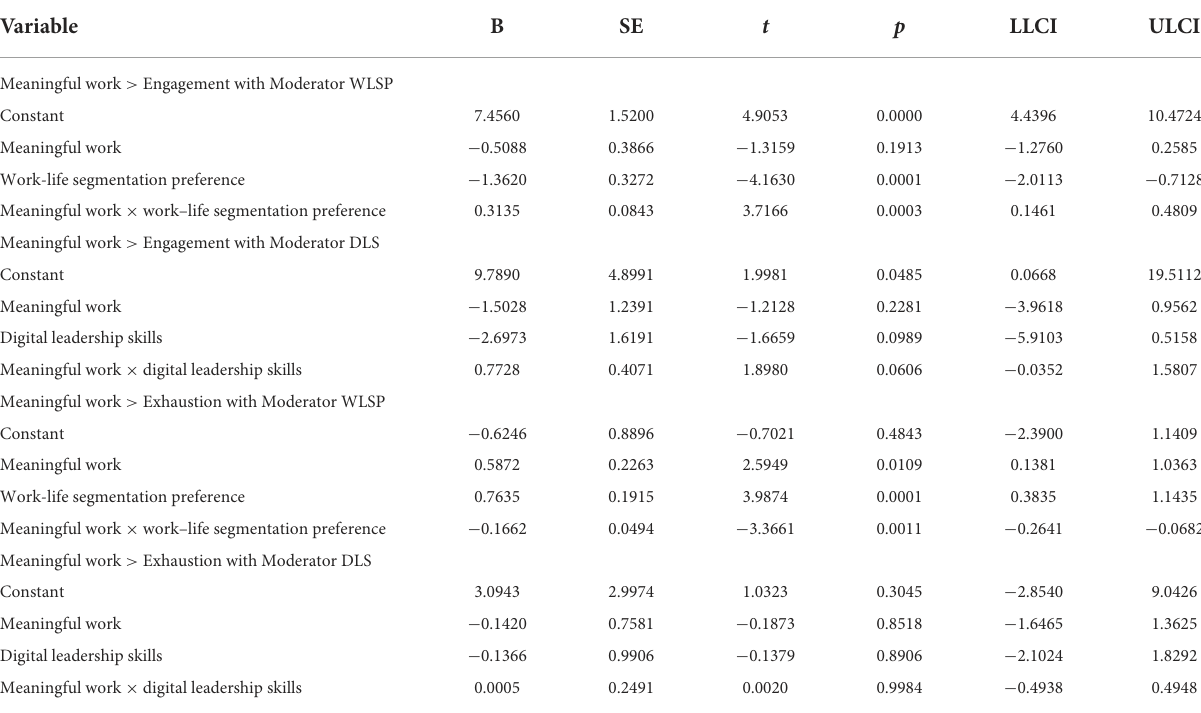
TABLE 3 Moderation